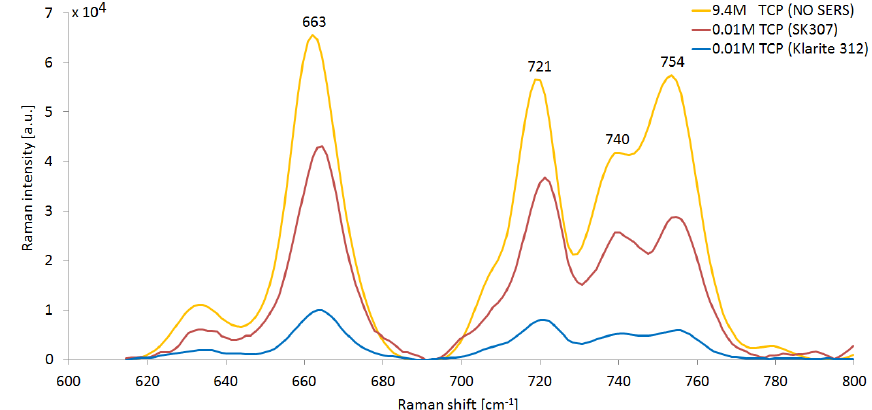
Figure 5. Comparison of conventional Raman spectrum of TCP with SERS on Klarite 312 and SK307. Conventional Raman spectrum was recorded from neat TCP, molar concentration 9.4 M. SERS spectra were recorded from 0.01 M (10 mM) TCP solutions on Klarite 312 and SK307. The horizontal axis represents Raman shift, while the vertical axis shows Raman (SERS) signal intensity. All the spectra were recorded with identical settings, as described in Section 2.4. The SERS peaks representing C-Cl stretching in TCP are present at 663 cm − 1 , 721 cm − 1 , 740 cm − 1 , and 754 cm − 1 . They are red shifted by about 1 cm − 1 relative to the conventional